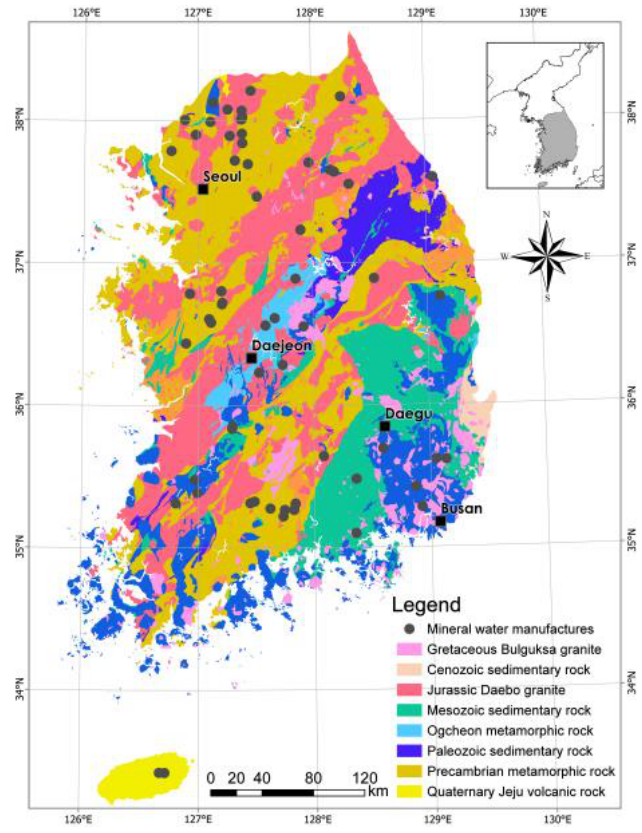
Figure 1. Geological map of South Korea and locations of mineral water bottlers facilities.